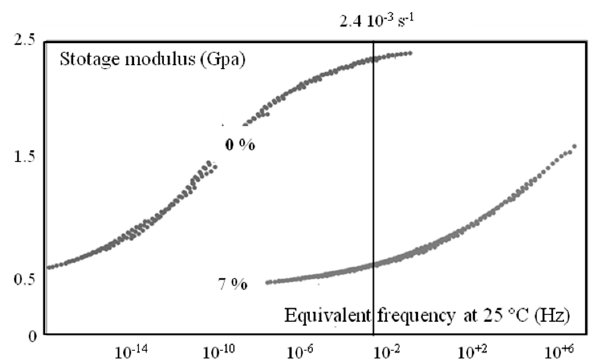
Figure 8. Master curves at a reference temperature of 25 °C for two water contents in the core of the plaque. The straight line illustrates the equivalent stain rate for tensile conditions (23 °C and 4 10 − 3 s − 1 ).